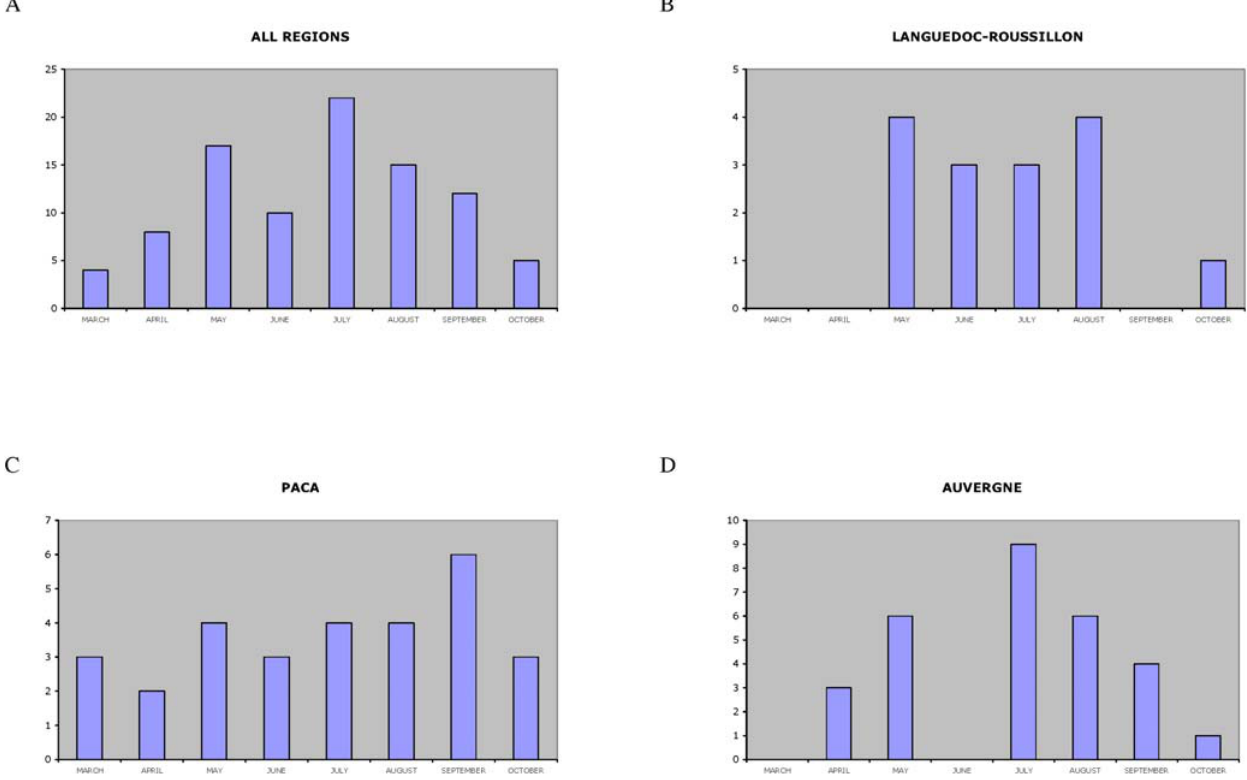
Figure 2. Annual distribution of envenomation cases in France.